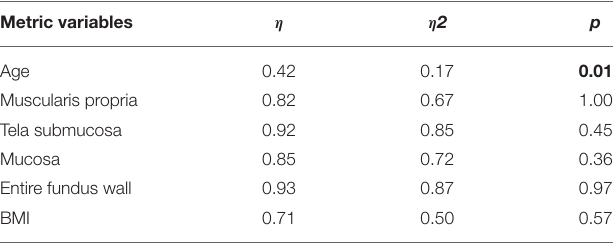
η and η 2 = effect size coefficients; p = value of significance; p > 0.05 = non-significant; η 2 < 0.06, small effect; η 2 = 0.06–0.14, middle effect; η 2 > 0.14, strong effect. Bold values are significance.